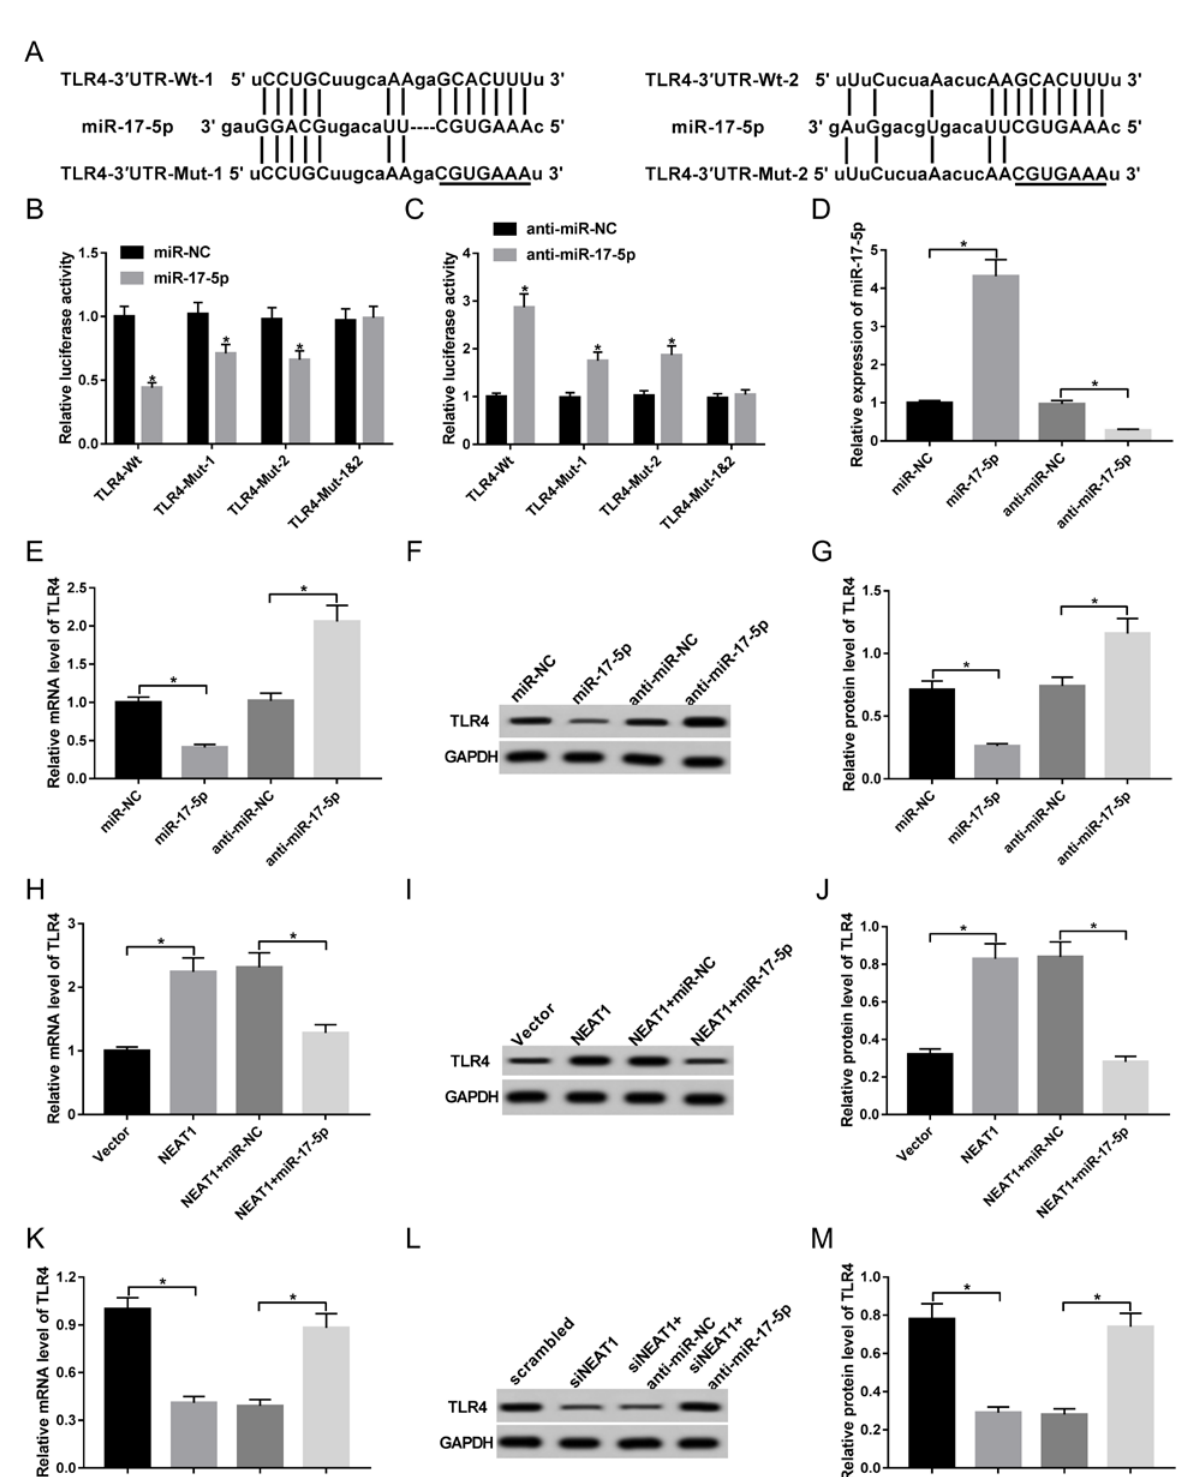
Figure 5: TLR4 is regulated by NEAT1 and miR-17-5p in macrophages. (A) The potential binding sites of miR-17-5p and TLR4. (B and C) Lucif- erase activity was detected in macrophages co-transfected with miR-17-5p, miR-NC, anti-miR-17-5p or anti-miR-NC and TLR4-Wt or TLR4-Mut. (D) The expression of miR-17-5p was detected in macrophages transfected with miR-NC, miR-17-5p, anti-miR-NC or anti-miR-17-5p. (E-G) The expression of TLR4 mRNA and protein was measured in macrophages transfected with miR-NC, miR-17-5p, anti-miR-NC or anti-miR-17-5p. (H-M) The level of TLR4 mRNA and protein was detected in macrophages transfected with vector, NEAT1, NEAT1 and miR-NC or miR-17-5p, scrambled, siNEAT1, siNEAT1 and anti-miR-NC or anti-miR-17-5p.